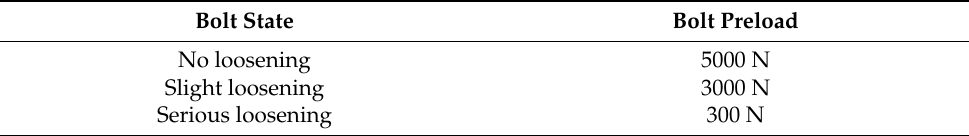
Table 1. Bolt state